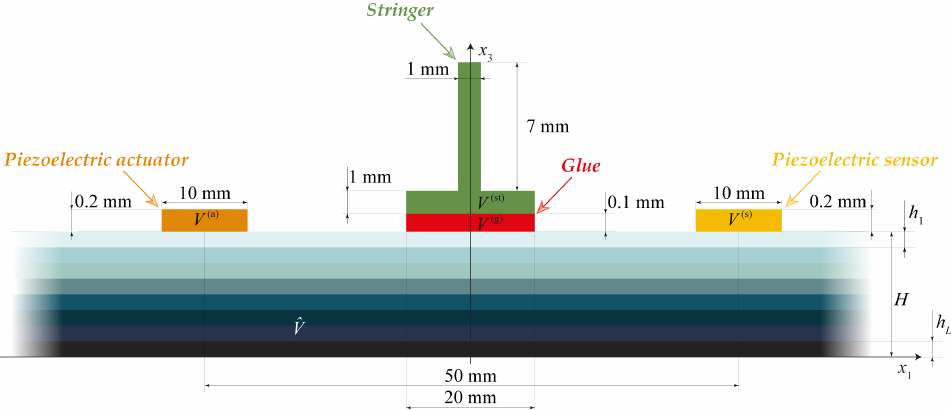
Figure 3. Geometry sketch of the considered plain-strain problem of EGW excitation, sensing, and